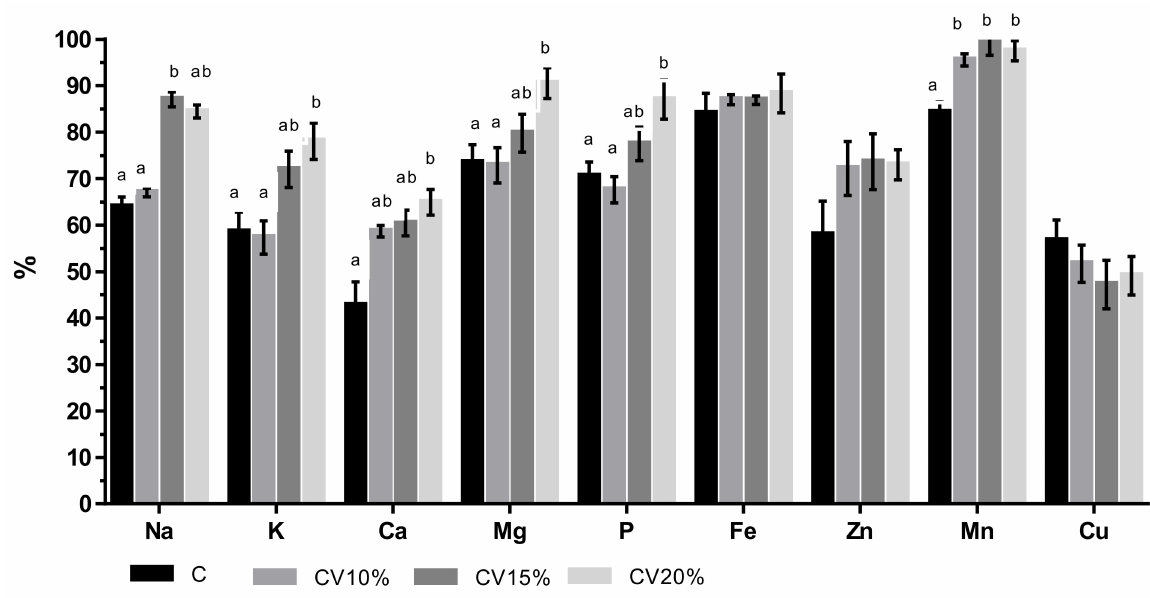
Figure 1. Mineral bioaccessibility in breast meat of broilers chickens fed different levels of C. vulgaris for 40 days. Data shown are mean ± SE, n = 6. a,b Different superscripts within a row indicate a significant difference ( p <